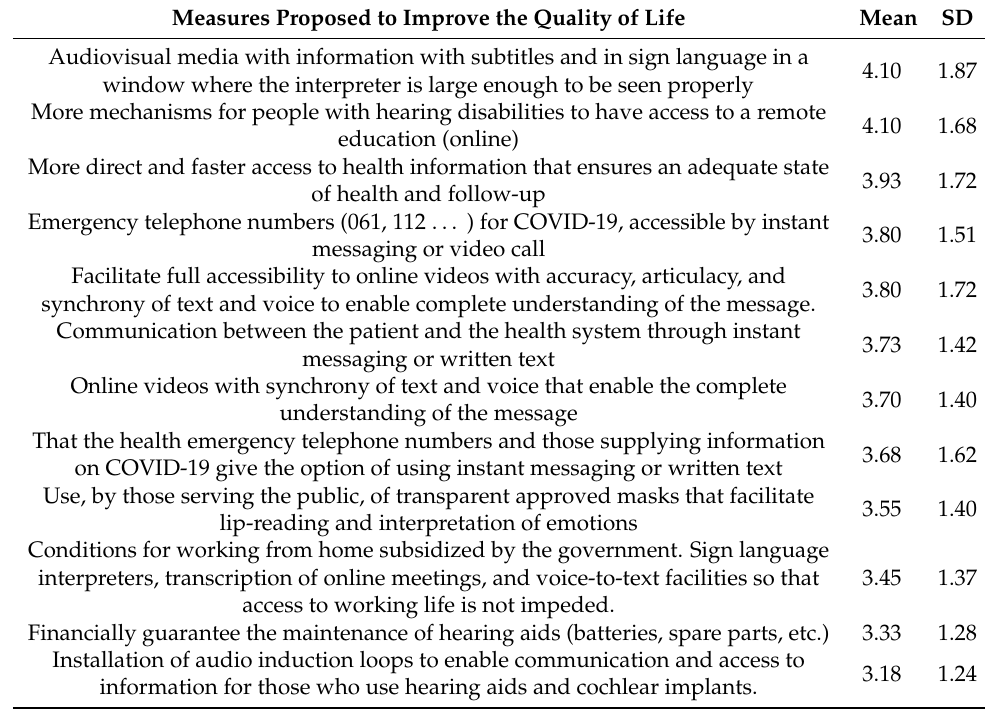
Table 5. Mean and standard deviation assessment of the importance of measures proposed to improve the quality of life of people with